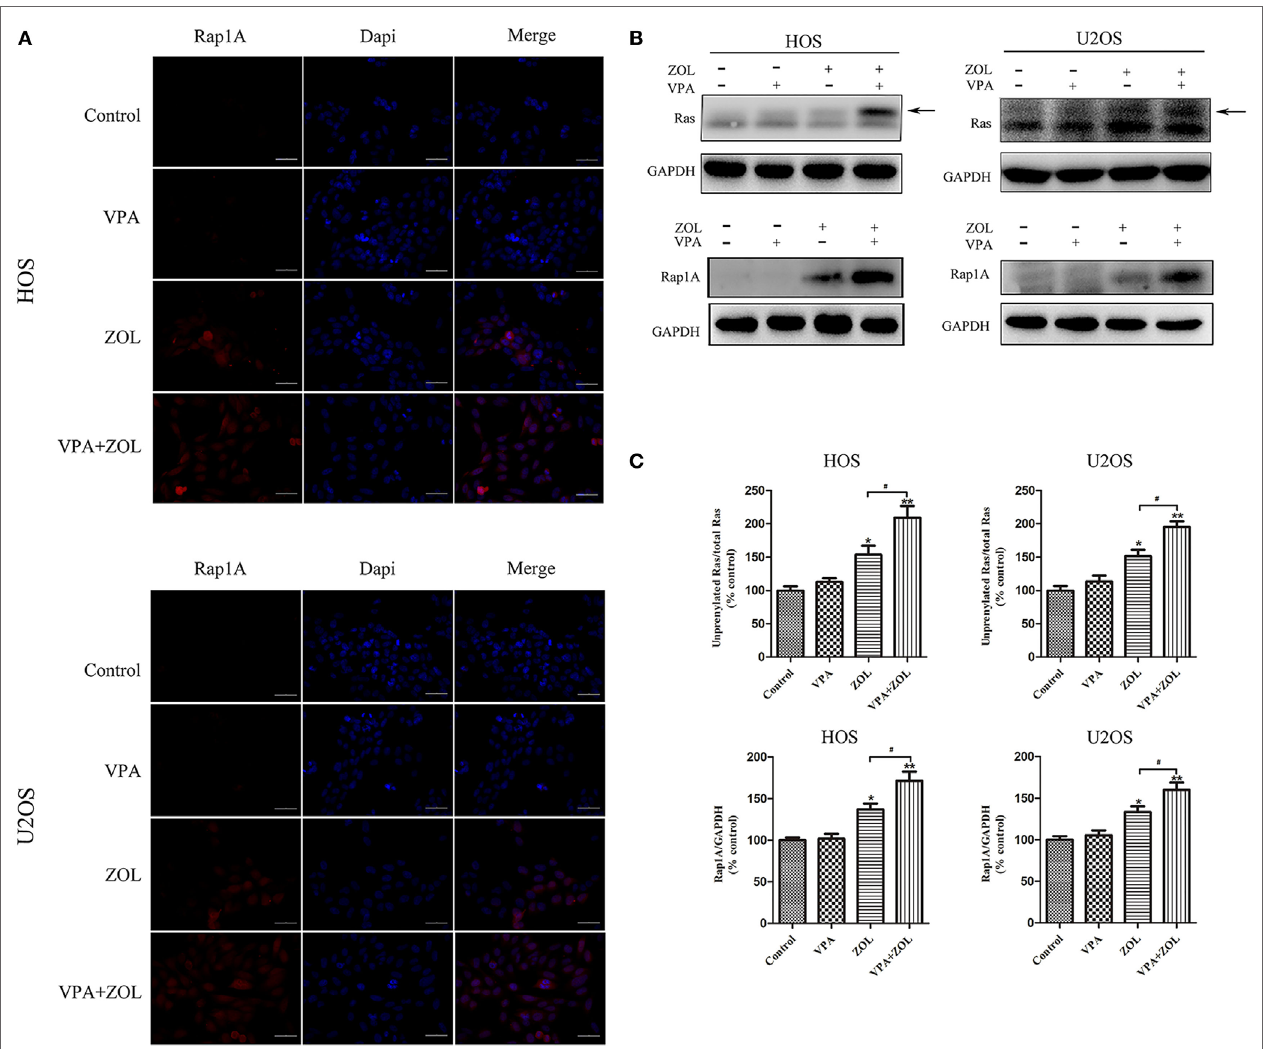
FigUre 3 | Valproic acid (VPA) and zoledronate (ZOL) inhibited prenylation of Ras and Rap1A in osteosarcoma cells. The expression levels of unprenylated proteins in HOS and U2OS cells with various treatments were detected by immunofluorescence and western blot. (a) The level of unprenylated Rap1A (red) was determined by fluorescence microscopy. The nuclei were counterstained with DAPI (blue). Scale bar: 50 µm. (B,c) The levels of unprenylated Rap1A and Ras were measured by western blot. The band marked by arrow corresponded to unprenylated form of Ras and the Rap1A antibody detected unprenylated form Rap1A. The levels of unprenyalted proteins were normalized and the relative values from three separate experiments were shown in histograms as mean ± SD; * p < 0.05, ** p < 0.01 versus control, # p <